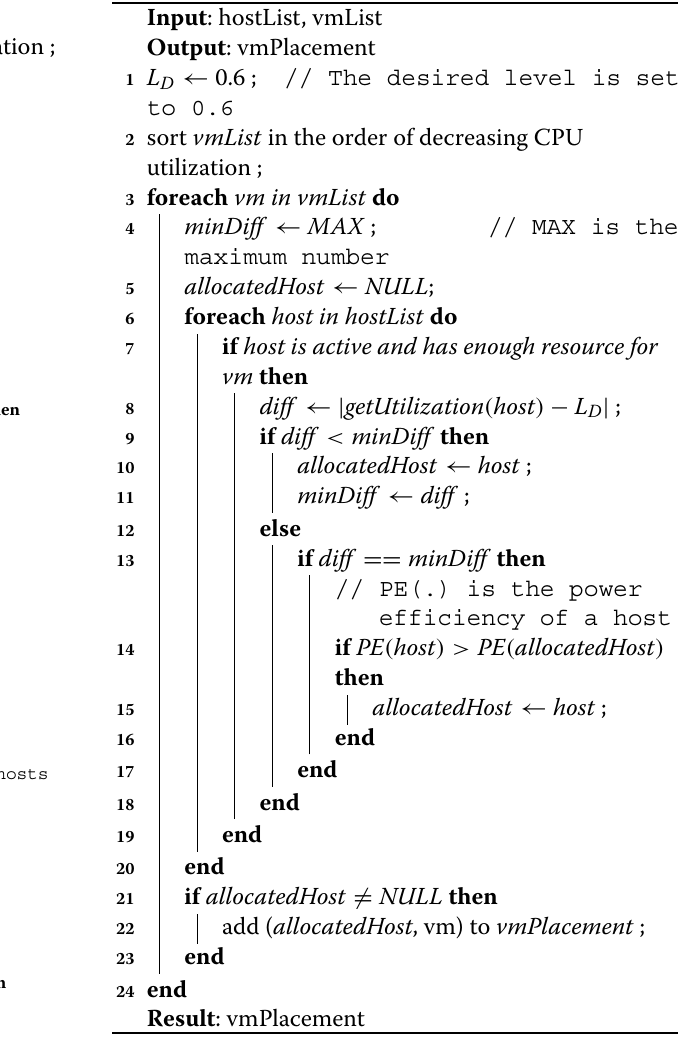
Algorithm 2: The Power Efficient Best-Fit Decreasing Algorithm 3: The Medium-Fit Power Efficient